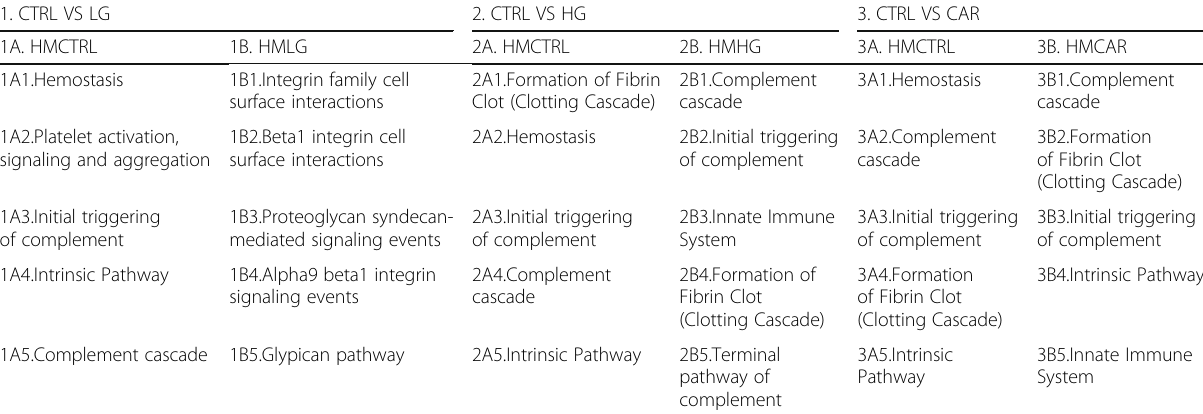
Table 1 Top 5 pathways enriched by FunRich 3.0. In comparing controls (CTRL) vs Low-garde (LG) and High-grade dysplasia (HG) and pancreatic carcinoma (CAR), the following pathways were found to be enriched. The pathways are given in the order of their degree of enrichment from top to bottom in every column. HM means highest mean